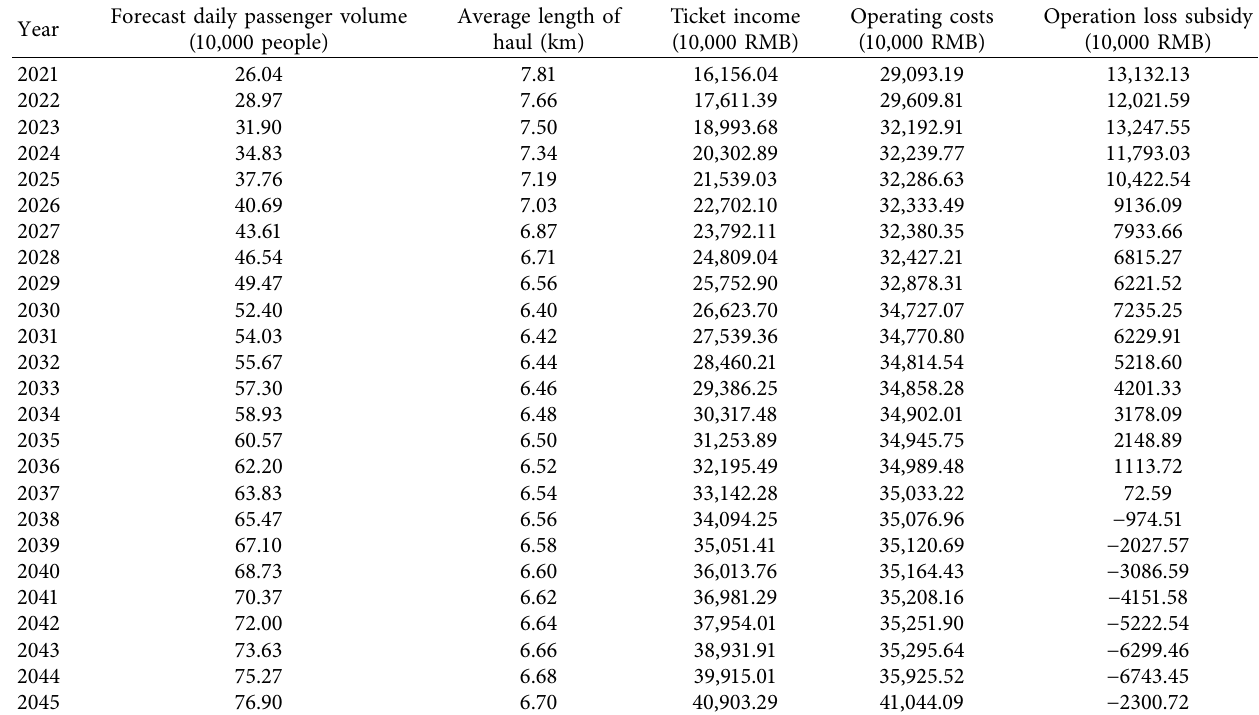
Table 3: The basic income and cost data of N City Metro Line 3